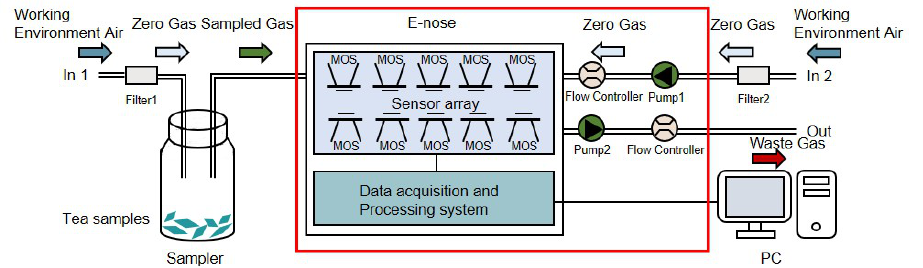
Figure 4. Schematic diagram of the PEN-3 workflow.